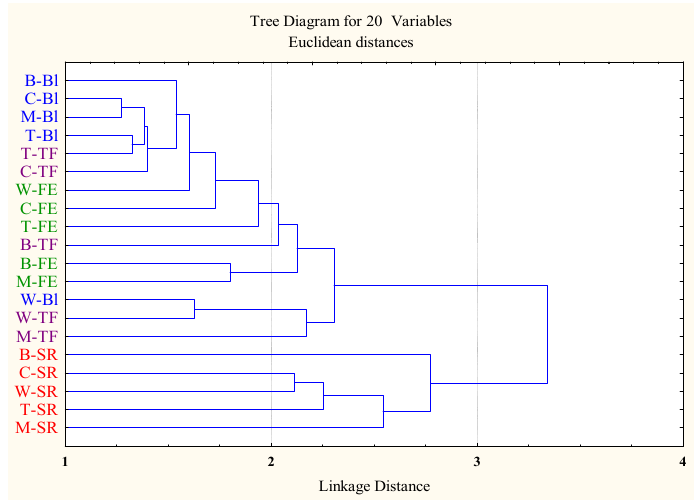
Figure 3. Dendrogram for cream samples obtained from the hierarchical cluster analysis.